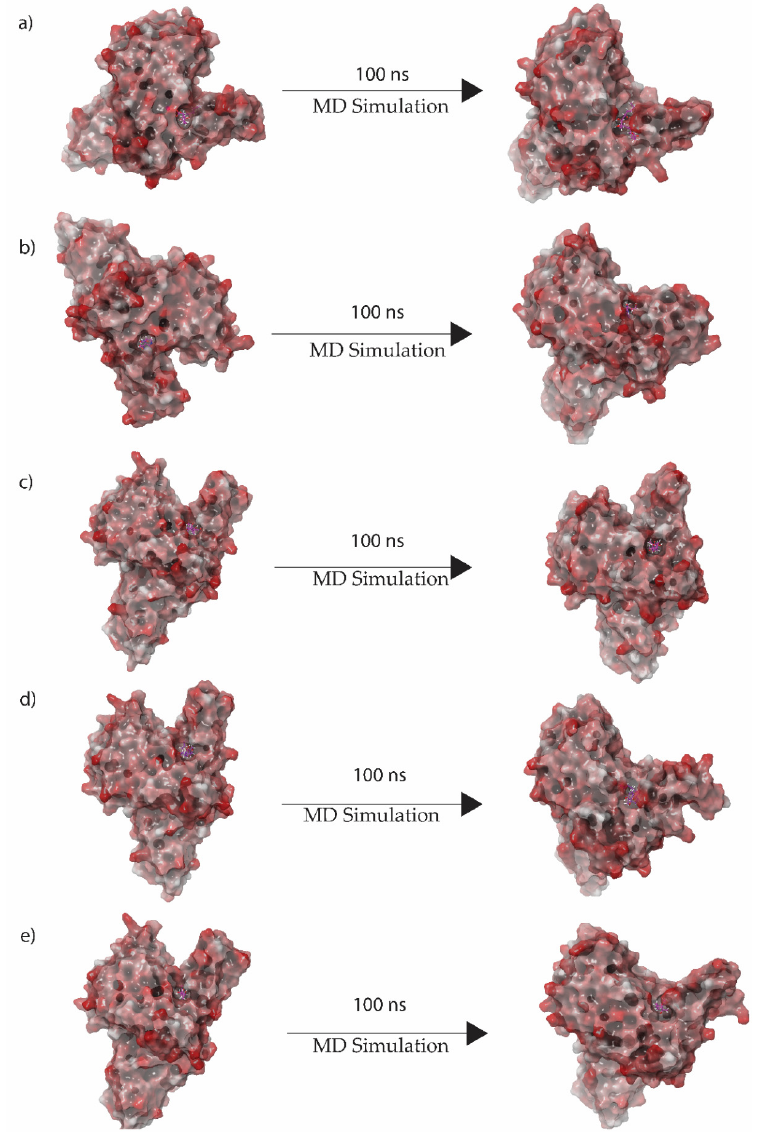
Figure 4. 3D position of initial and final docked poses of ( a ) Gallicynoic Acid F, ( b ) H2 Erythro-Neopterin, ( c ) Nigcollin C, ( d ) NPA024545, and ( e ) Vaccinol M extracted from the 100 ns MD simulation.